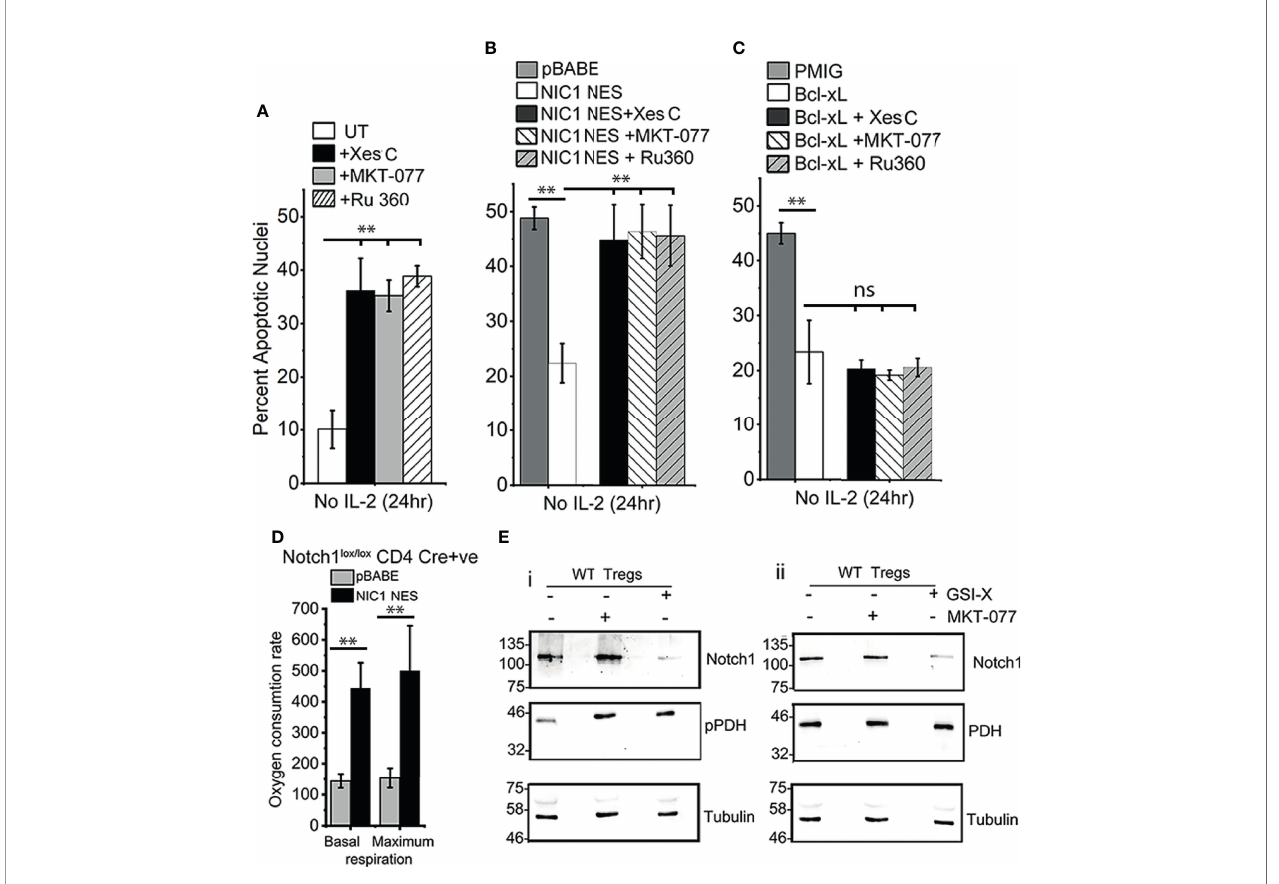
FIGURE 5 | NIC1-mediated Treg survival requires IP3Rs, Grp75 and MCU. (A) Percent apoptotic nuclei in activated WT Tregs cultured without IL-2 for 24 h with vehicle control (UT) or, 5 m M Xestospongin C or, 10 m M MKT-077 or, 10 m M Ru360. (B, C) Percent apoptotic nuclei in Notch1 -/- Tregs transduced with pBABE or NIC1-NES (B) or pMIG or Bcl-xL (C), and cultured without IL-2 for 24 h with vehicle control, or 5 m M Xestospongin C or, 10 m M MKT-077 or, 10 m M Ru360. (D) Basal and maximum OCR, computed as described in methods, in Notch1 -/- Tregs transduced with pBABE or NIC1-NES. (E) Immunoblot of whole cell lysates prepared from activated WT Tregs cells cultured with or without 10 m M GSI-X or 10 m M MKT-077 for 8 h and the samples run in duplicate. Membrane was probed either for (p)PDH, Notch1 and Tubulin (E-i) or PDH, Notch1 and Tubulin (E-ii) . The immunoblot is representative of two independent experiments. Data are mean ± SD of three independent experiments (A – C) and readings in 4 wells from two independent experiments (D). ** indicates signi fi cant difference with p-value ≤ 0.01 and ns, not signi fi cant, examined using unpaired student ’ s